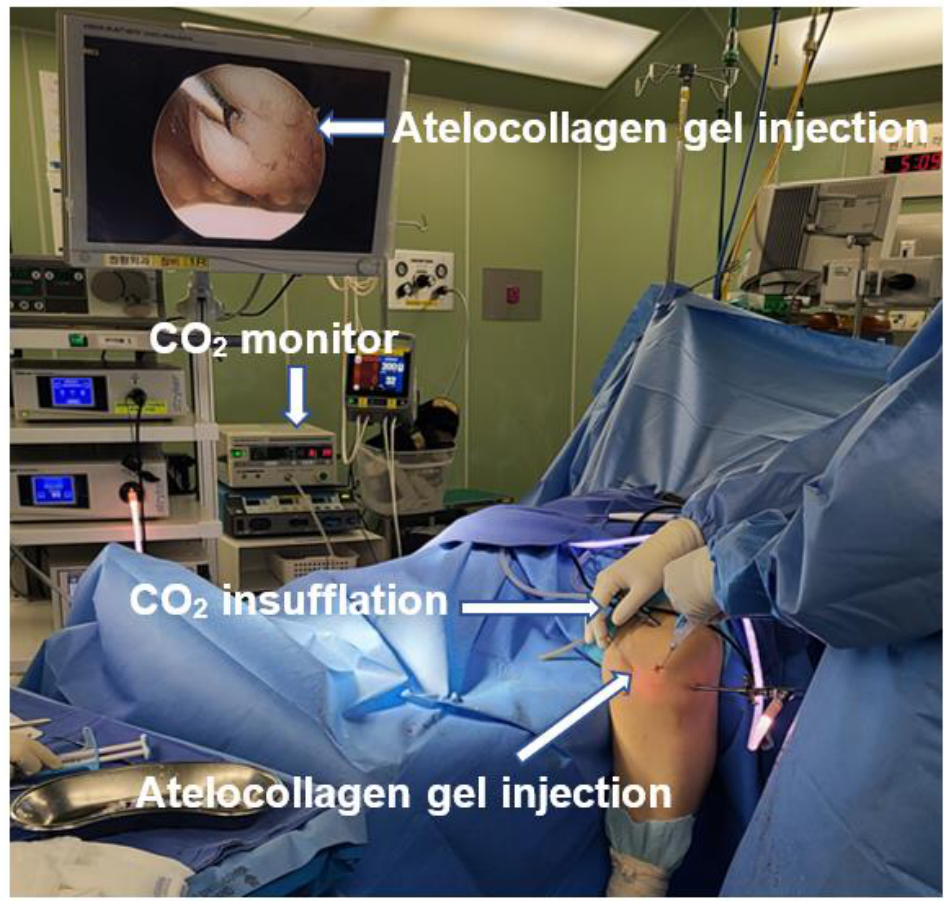
Figure 9. Arthroscopic settings for ACIC.